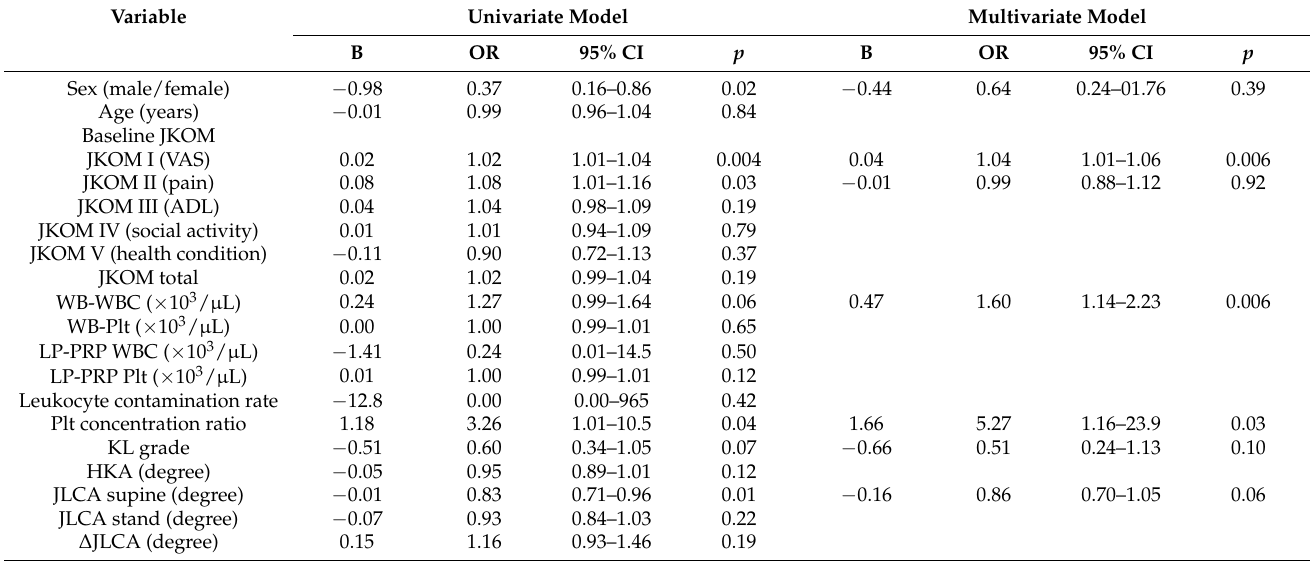
Table 4. Regression